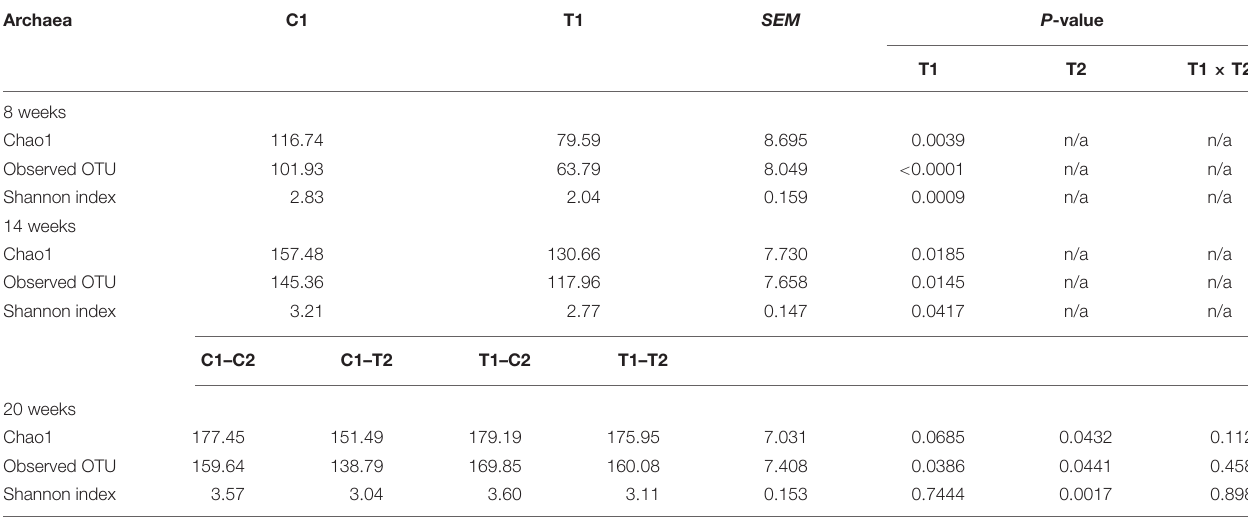
TABLE 3 | Alpha diversity of archaeal community (Chao 1, observed OTU and Shannon index) in the rumen of control lambs (C1) and lambs treated with a linseed-garlic combination (T1) from birth up to 10 weeks of